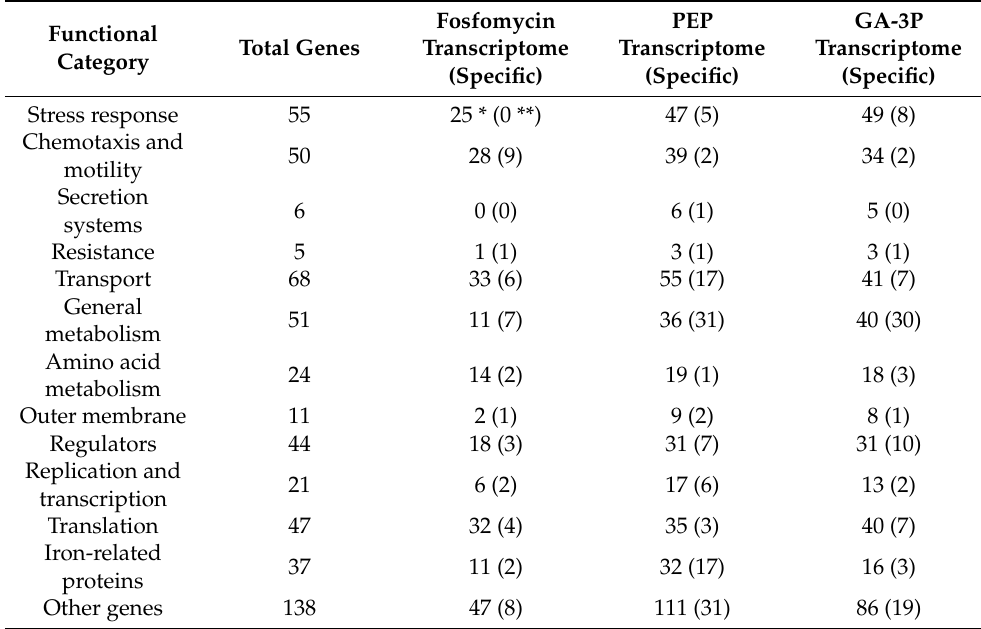
Table 1. Number of genes with expression changes in each functional